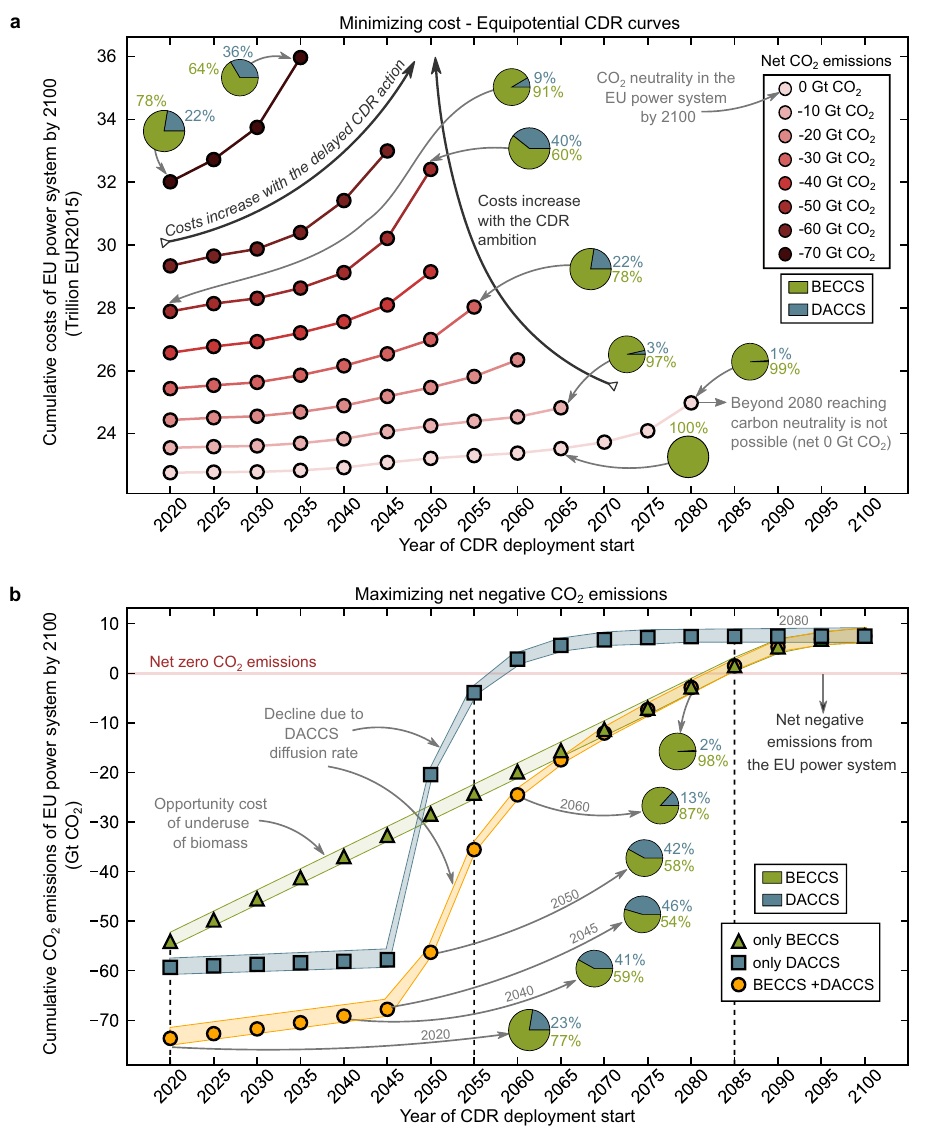
Fig. 1 Implications on costs and emissions of delayed-actions on carbon dioxide removal (CDR) considering different starting points for bioenergy with carbon capture and storage (BECCS) and direct air carbon capture and storage (DACCS) deployment until 2100 (x-axis). Subplot ( a ) shows the minimum costs of the European power system associated with increasing CDR targets. Subplot ( b ) shows the maximum cumulative net CDR that could be attained considering the deployment of BECCS and DACCS from a particular point in time onwards (green pro fi le only with BECCS, blue with DACCS, and yellow considering both BECCS and DACCS). Dots correspond to the optimal solutions for the 5-year time steps starting in 2020 and ending in 2100. The shaded area in subplot ( b ) indicates the uncertainty in the life cycle CO 2 emissions (i.e., μ ± 2 σ , Methods for details on the uncertainty analysis). The pie charts illustrate the proportion of gross CDR provided with BECCS and DACCS,